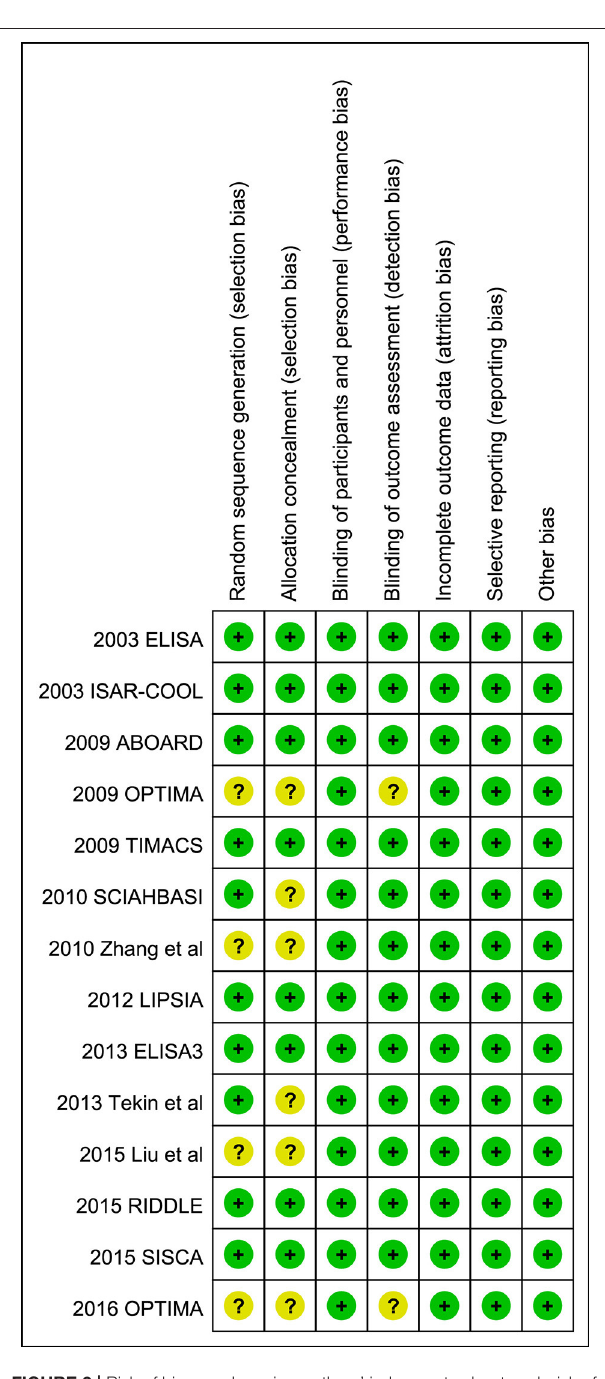
intervention were well-matched for demographic and clinical